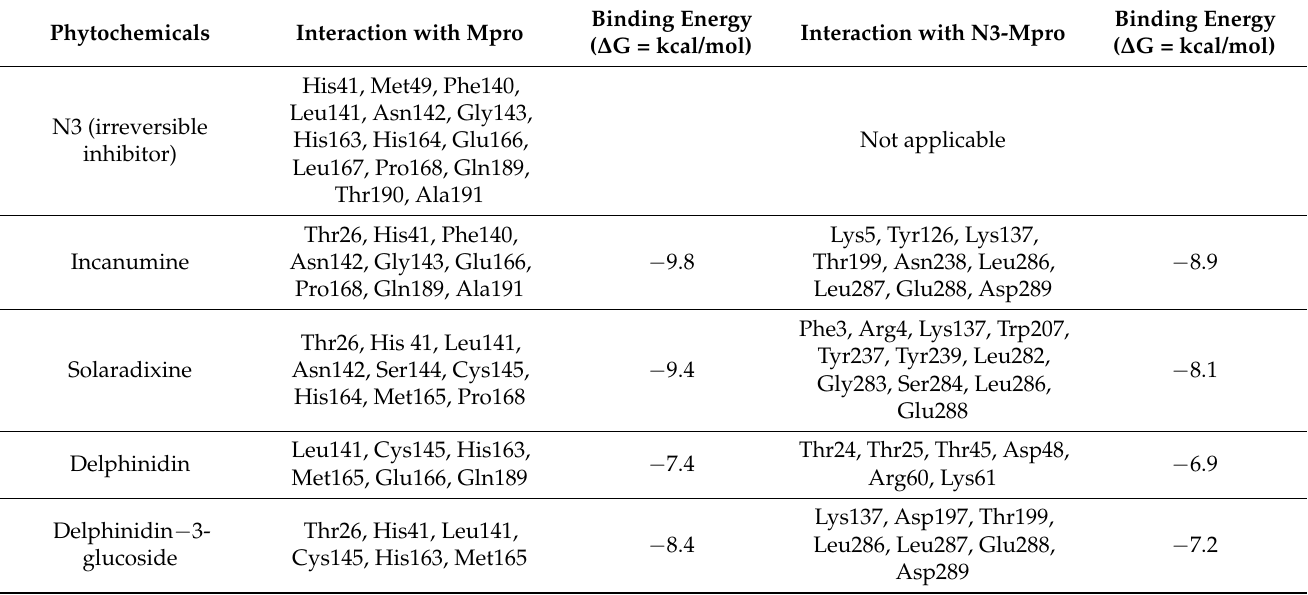
Table 6. Binding of incanumine, solaradixine, delphinidin, and delphinidin-3-glucoside with Mpro and N3-bound Mpro.